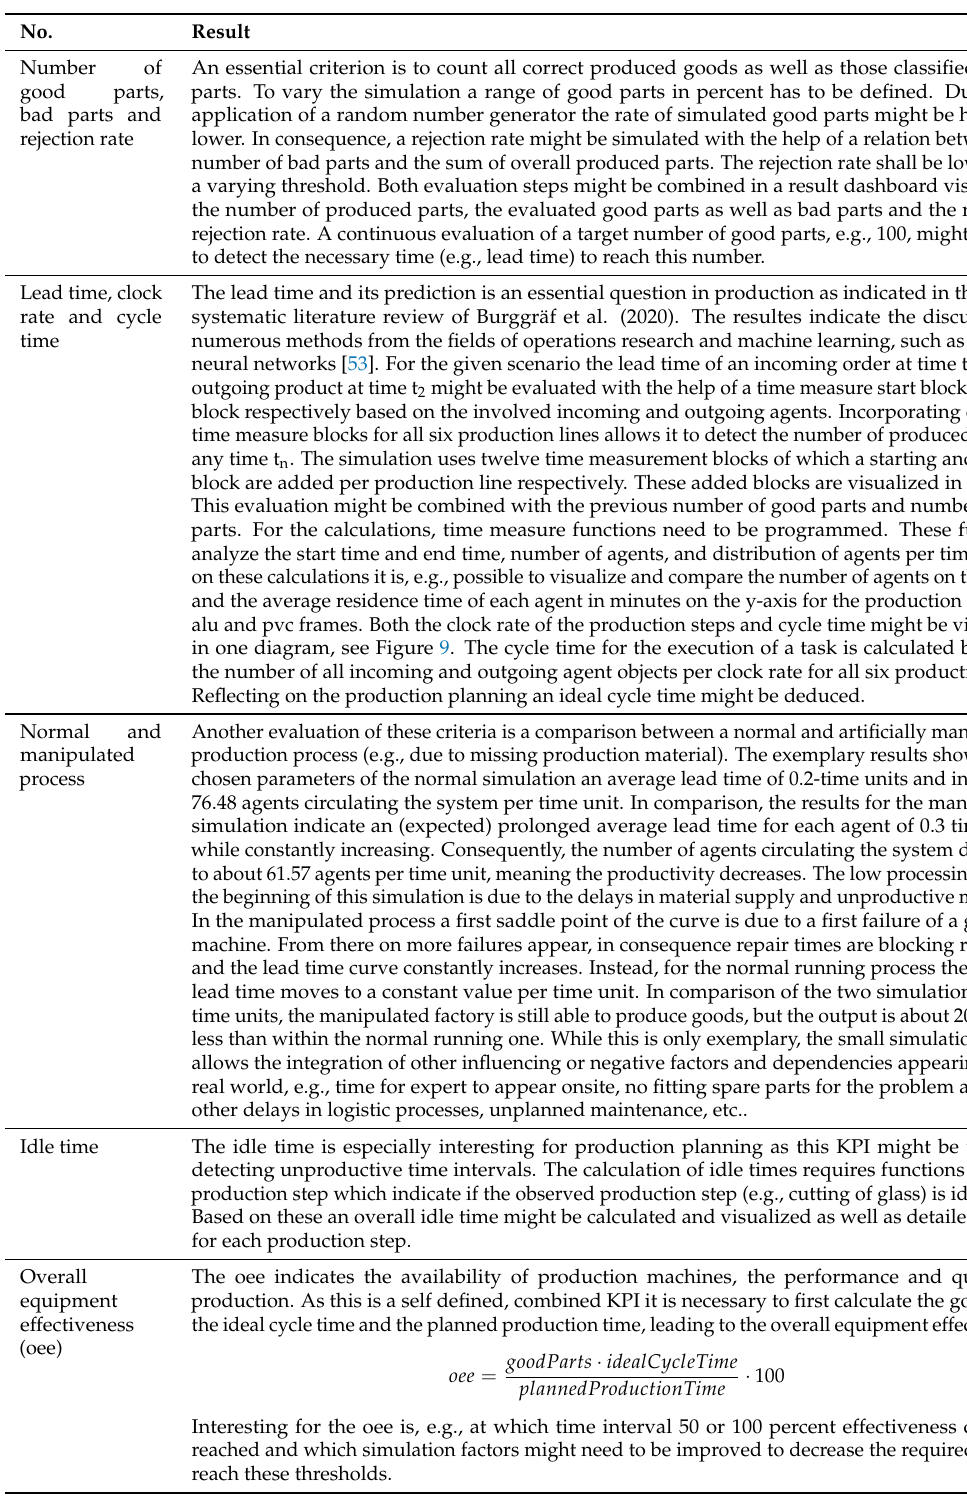
Table 5. Simulation